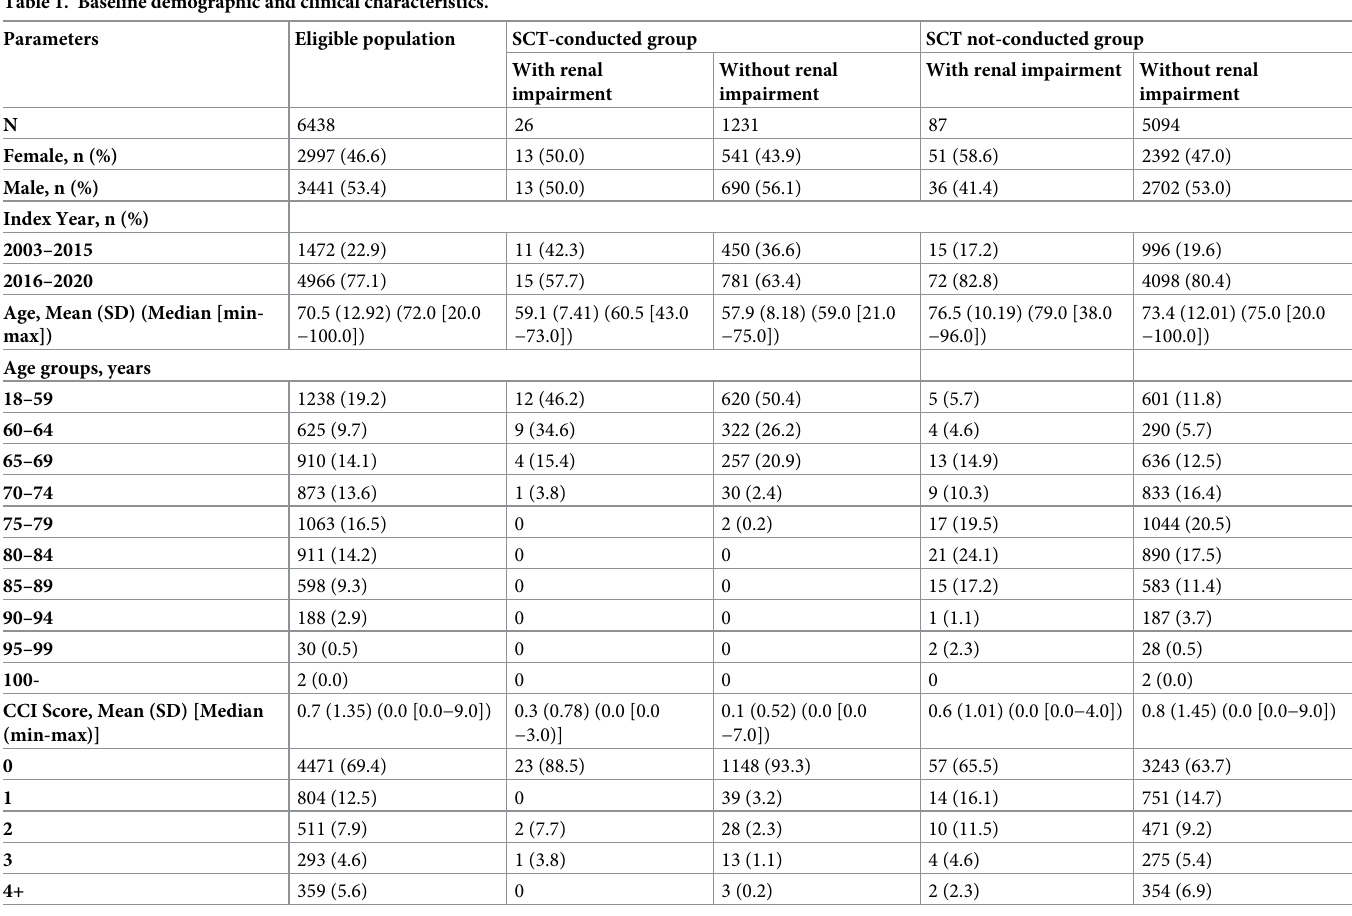
Table 1. Baseline demographic and clinical